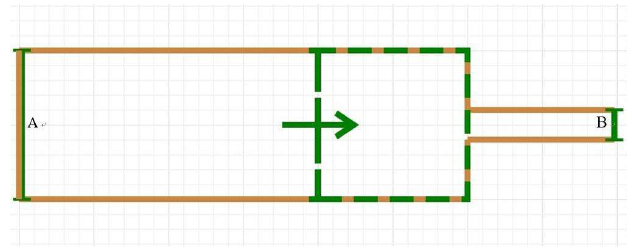
Figure 3. Basic scene in simulation experiment.